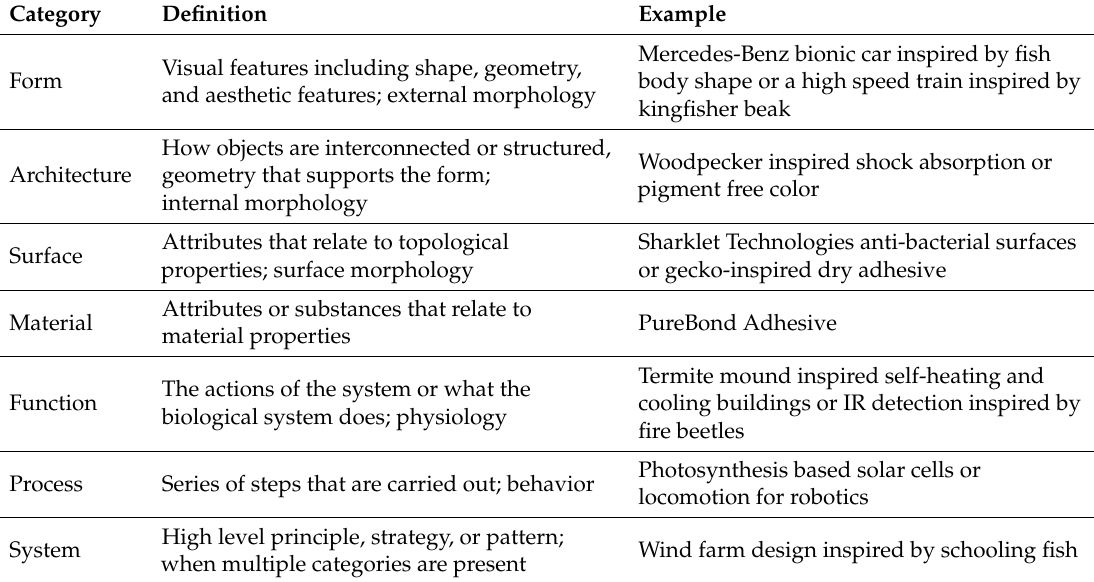
Table 1. Analogy Category Definitions and Examples